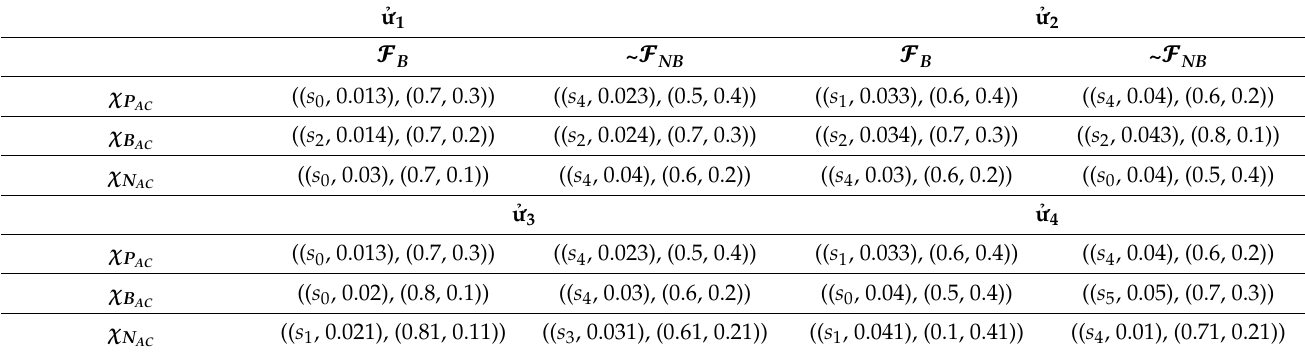
Table 10. Loss functions for D DE − 3